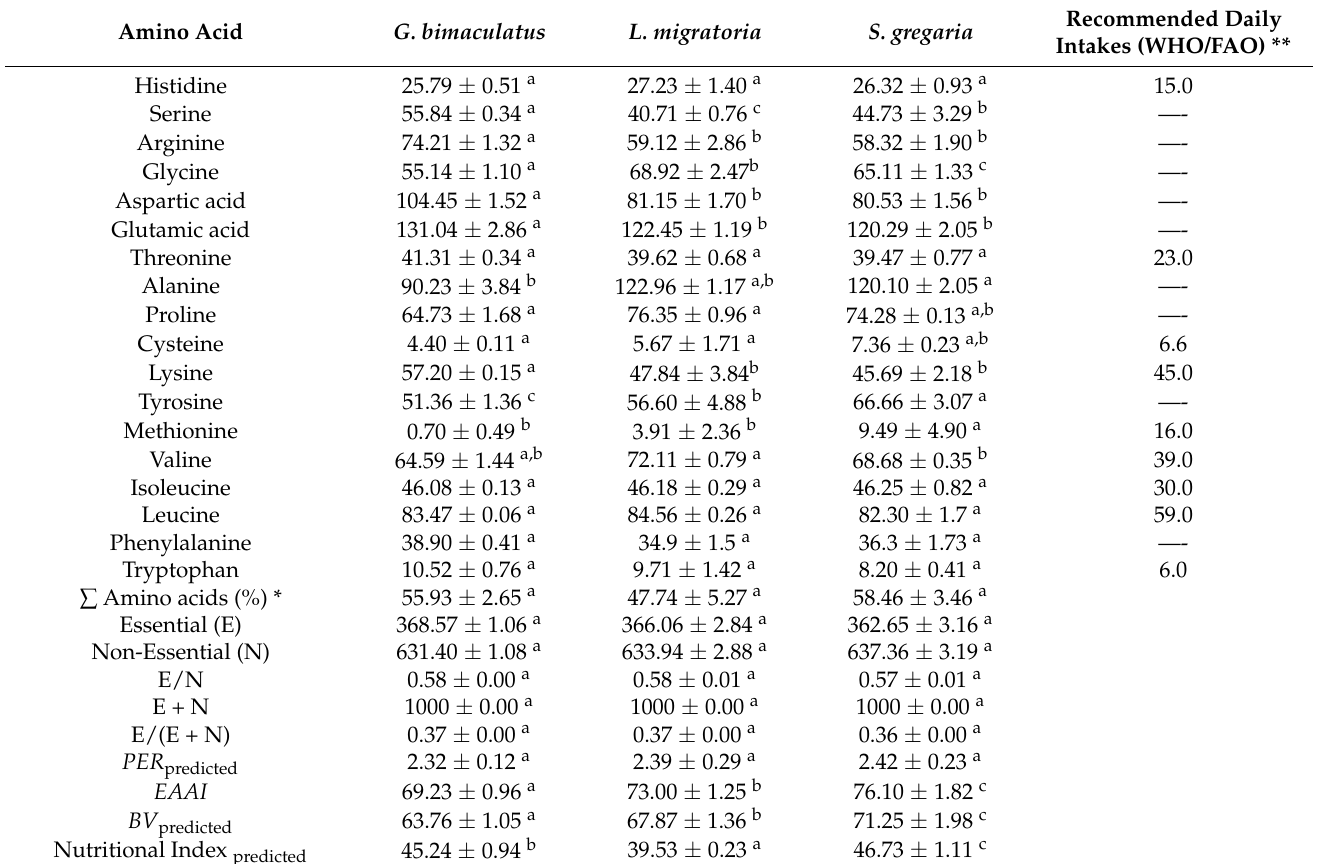
NFE = nitrogen-free extract. a , b , c Mean values in the same row with a different letter superscript are significantly different ( p < 0.05). Table 3. Amino acid profile (in mg/100 g protein), recommended daily intake, and predicted protein quality indicators of G. bimaculatus , L. migratoria , and S. gregaria : each value represents the mean ± standard deviation of triplicate determinations. Amino Acid G. bimaculatus